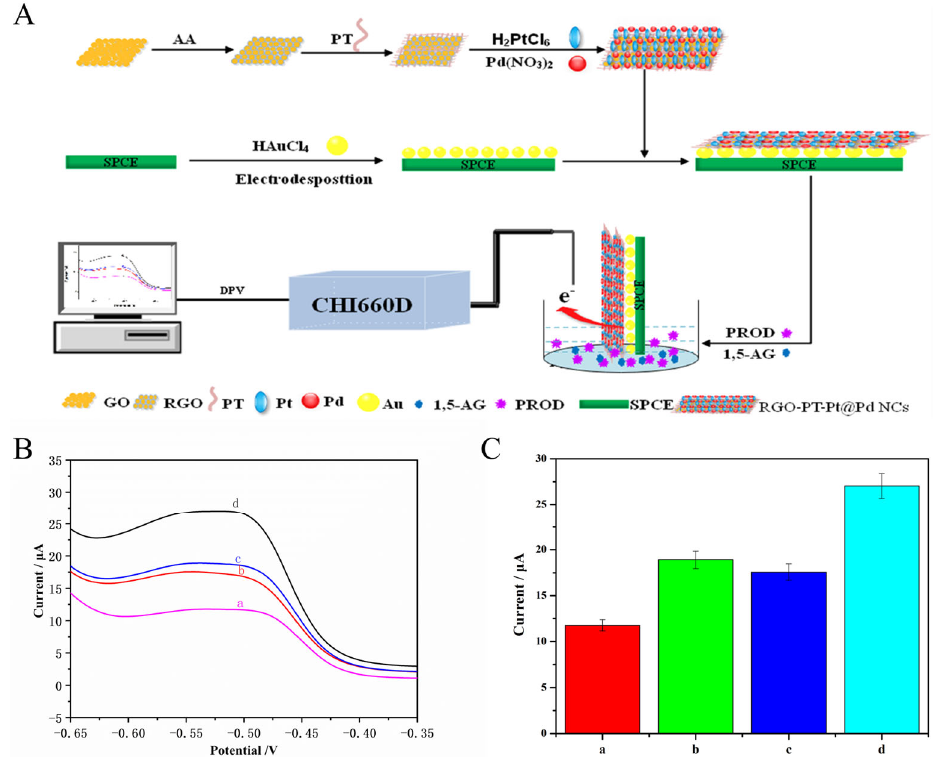
Figure 2. ( A ) Schematic diagram of an electrochemical sensor based on PT-rGO-PtPd NCs for 1,5-AG detection. ( B ) DPV maps of the feasibility of 1,5-AG detection performed by different electrochemical sensors in a PBS solution (0.1 mol/L; pH 7.0). (a) PT-rGO-PtPd NCs/Au NPs/SPCE, (b) 1,5-AG (0.1 mg/mL) /PT-rGO-PtPd NCs/Au NPs/SPCE, (c) PROD/PT-rGO-PtPd NCs/Au